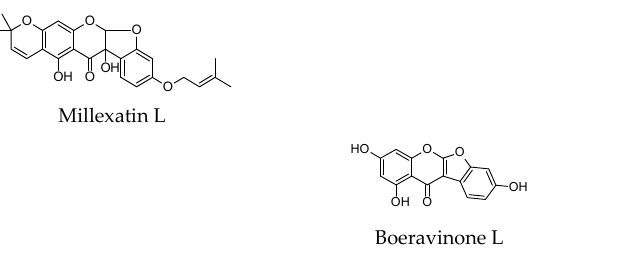
Figure 11. Structures of discussed pterocarpans.